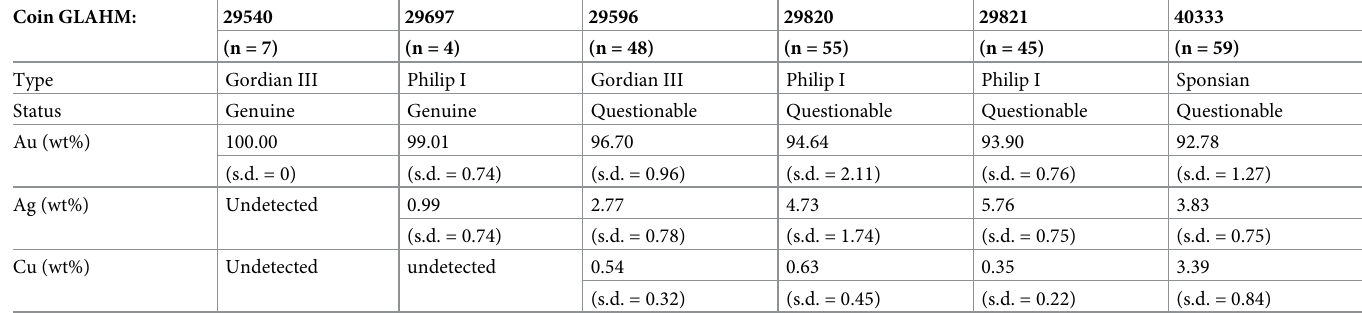
Table 3. Composition of the six coins analysed in this study according to SEM-EDX (wt%—weight percent, n = number of analysis points averaged, s.d. = standard deviation). Note that because a value of 0 wt% is automatically returned for analyses below the practical detection limit in the range 0.0–0.5 wt%, such results were assigned a value of 0.25 wt% for the purposes of plotting and the calculation of averages. Coin GLAHM: